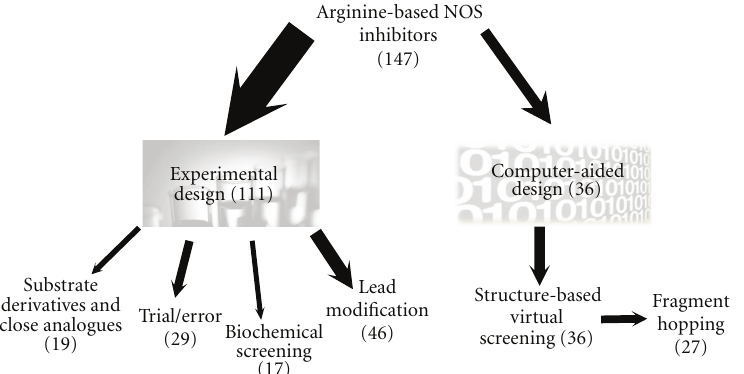
Figure 2: Summary of the use of current methods of inhibitor design among arginine-based NOS inhibitors. For a description of individual approaches see the chapter “Current methods of inhibitor design among arginine-based NOS inhibitors”. The width of arrows indicates the proportion in total number of arginine-based inhibitors. Only compounds for which quantitative data on the inhibition of at least one NOS isoform have been published were considered for this